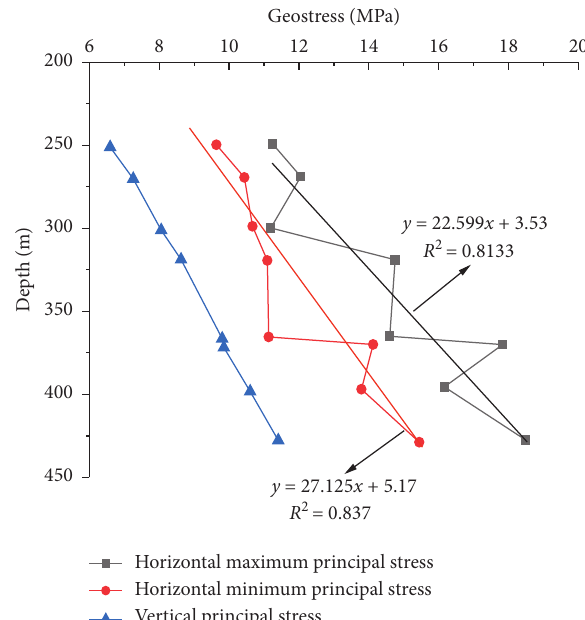
Figure 5: Map of principal stress variation with depth in the Mu Zhai-ling tunnel